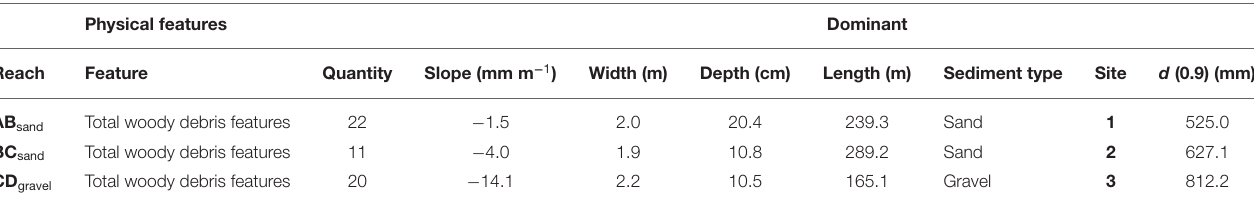
TABLE 1 | Key characteristics of the experimental reaches and streambed chemistry sampling sites including a survey of woody debris and in-stream features completed in July